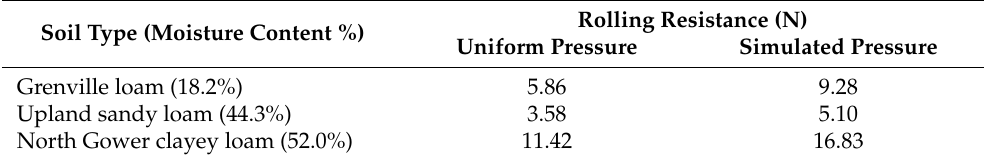
Table 2. Motion resistance for three soil types: values calculated with a uniform pressure and with simulated